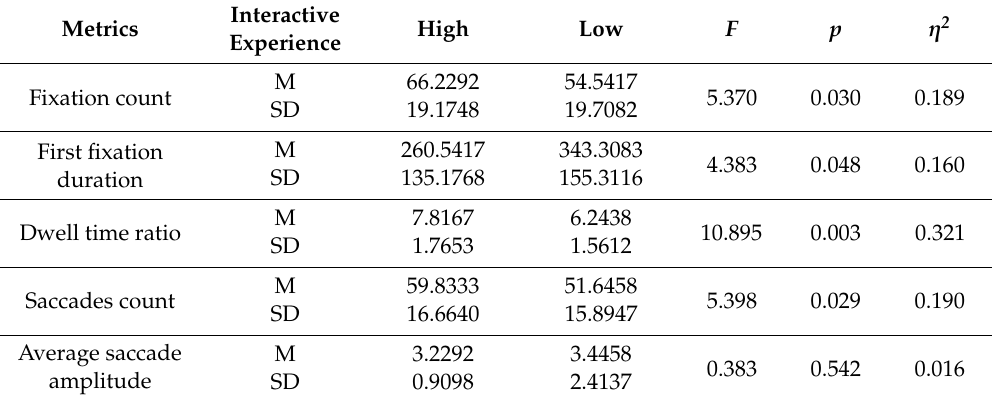
Table 3. Repeated measurement ANOVA of eye-movement metrics in the task-oriented